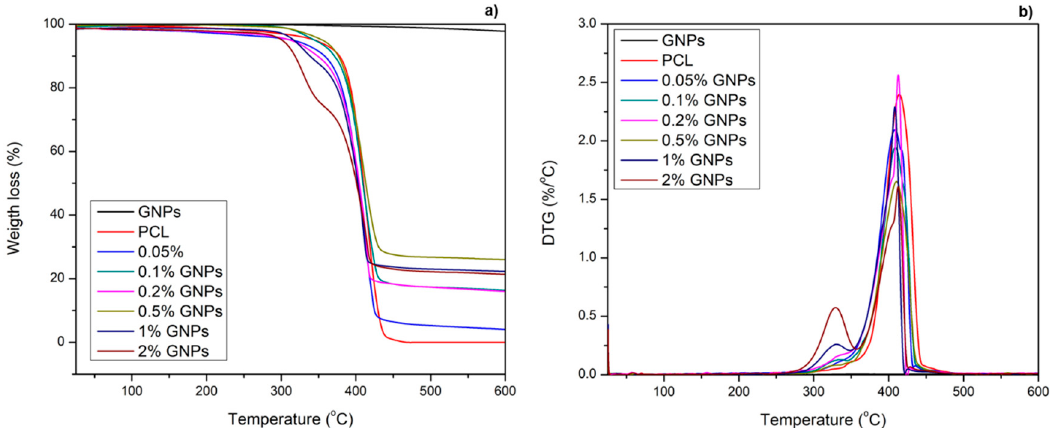
Figure 7. Thermogravimetric Analysis (TGA) ( a ) and Derivative Thermogravimetry (DTG) ( b ) curves of GNPs, PCL, and GNPs-PCL membranes with different percentages of GNPs.